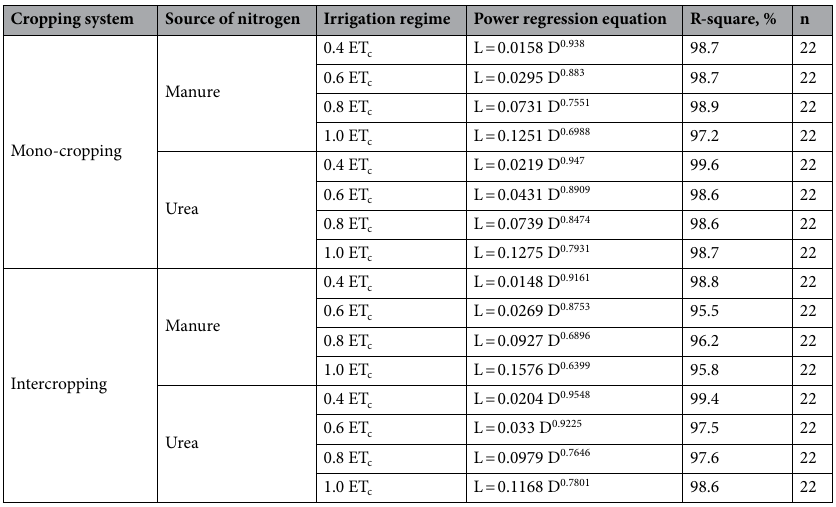
Table 4. The relationship between cumulative leached nitrogen (L) in kg N ha -1 and cumulative drained water (D) in